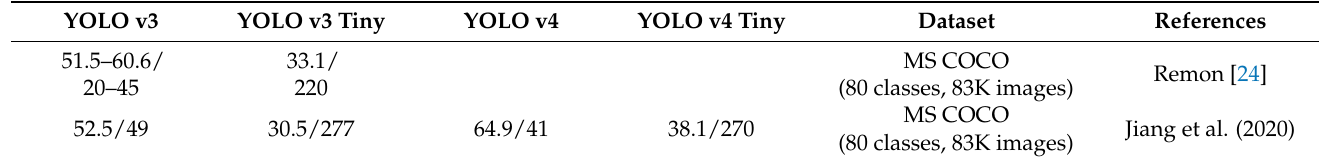
Table 5. YOLO model performances (Accuracy(mAP)/Speed(fps)) comparison in previous studies. YOLO v3 YOLO v3